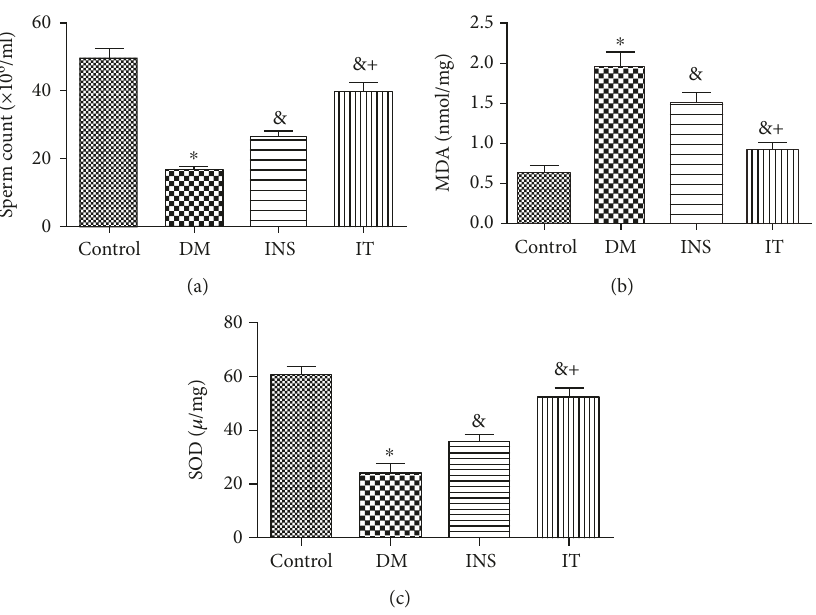
Figure 3: Islet transplantation treatment alleviated sperm count, MDA level, and SOD activity in the testicular tissue of diabetic rats. (a) The number of sperm in the DM group signi fi cantly decreased compared with that in the control group. The IT group showed more signi fi cant recovery of sperm cells compared with that in the INS group ( n = 6 for each group). (b) MDA contents in the DM group increased more extensively than that in the control group. Compared with that of the INS group, the MDA concentration of the IT group decreased more signi fi cantly ( n = 6 for each group). (c)The SOD activity in the DM group was signi fi cantly lower than that in other groups, and the IT group maintained signi fi cantly higher levels of SOD activity compared with that of the INS group ( n = 6 for each group). DM: diabetes mellitus; INS: insulin treatment; IT: islet transplantation. ∗ P < 0 05 vs. control; & P < 0 05 vs. DM; + P < 0 05 vs.